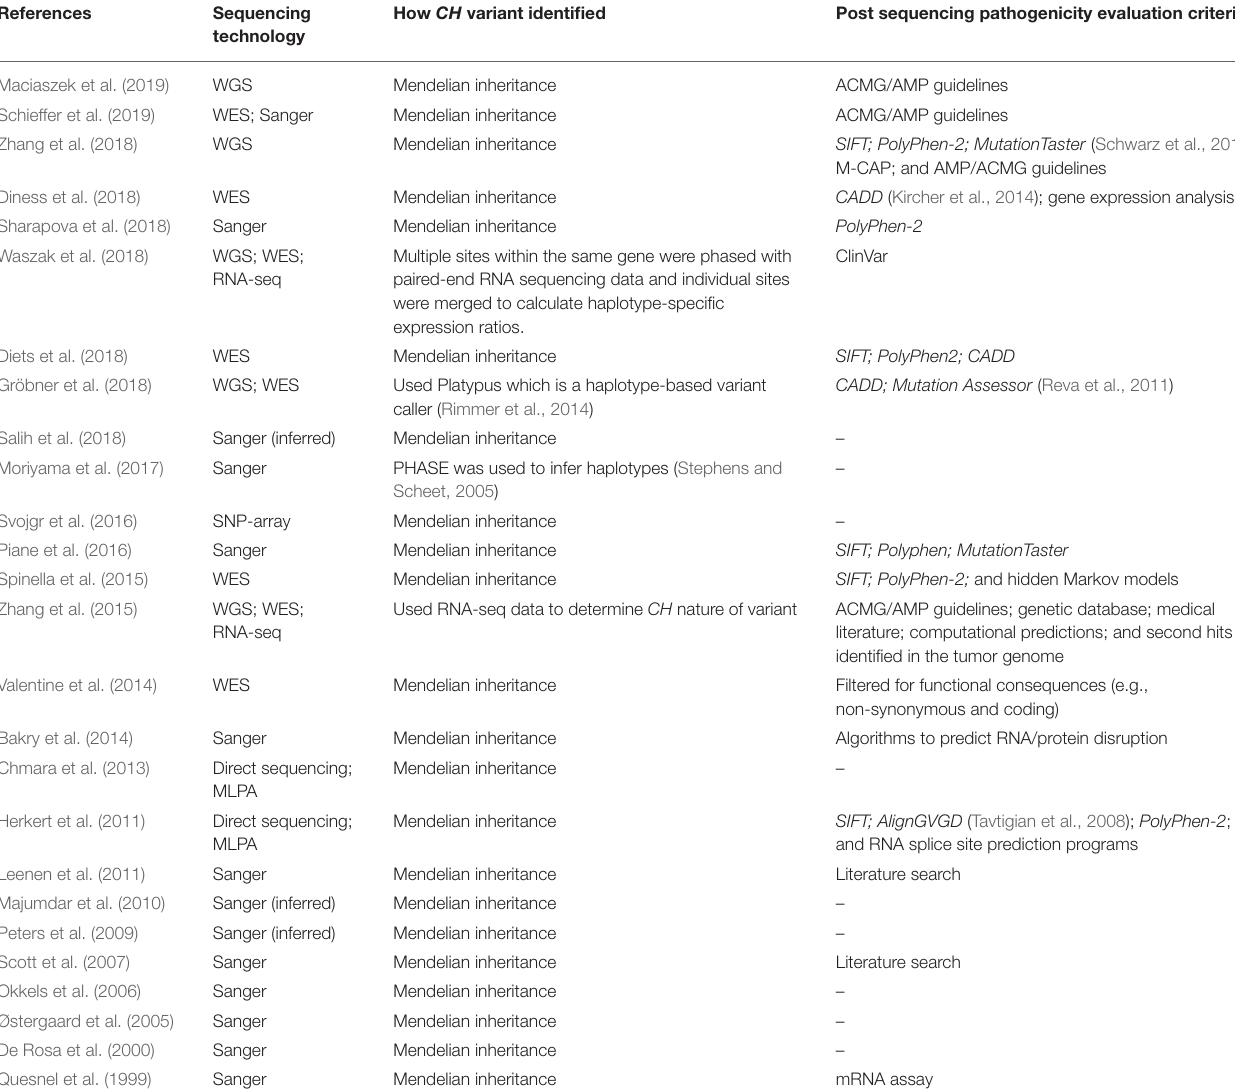
TABLE 3 | Methods used by each study for identification and evaluation of CH